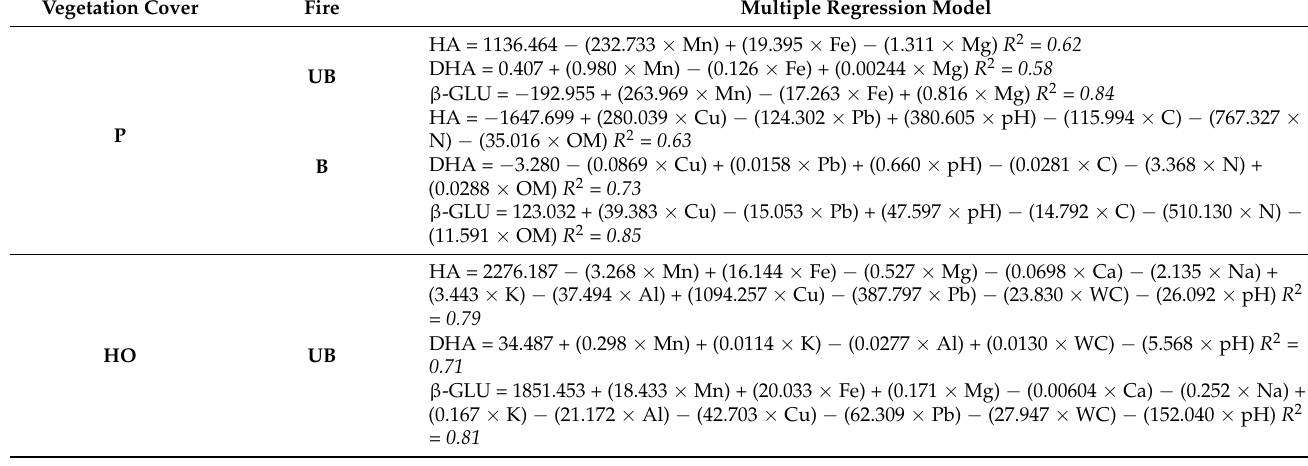
Table 6. Results of multiple linear regression analyses for unburnt and burnt soils under different vegetation covers. Significant results of multiple linear regression analyses of soil enzymatic activities (hydrolase: HA, dehydrogenase: DHA and β -glucosidase: β -GLU) in relationship with soil abiotic properties (pH, water content: WC, total concentration of carbon and nitrogen: C and N, organic matter content: OM, available fraction of Al, Ca, Cu, Fe, K, Mg, Mn, Na, and Pb) in unburnt (UB) and burnt (B) soils covered by different vegetation cover (P: pine; HO: holm oak; BL: black locust; H: herbs). Italics indicate the adjusted R 2 of each